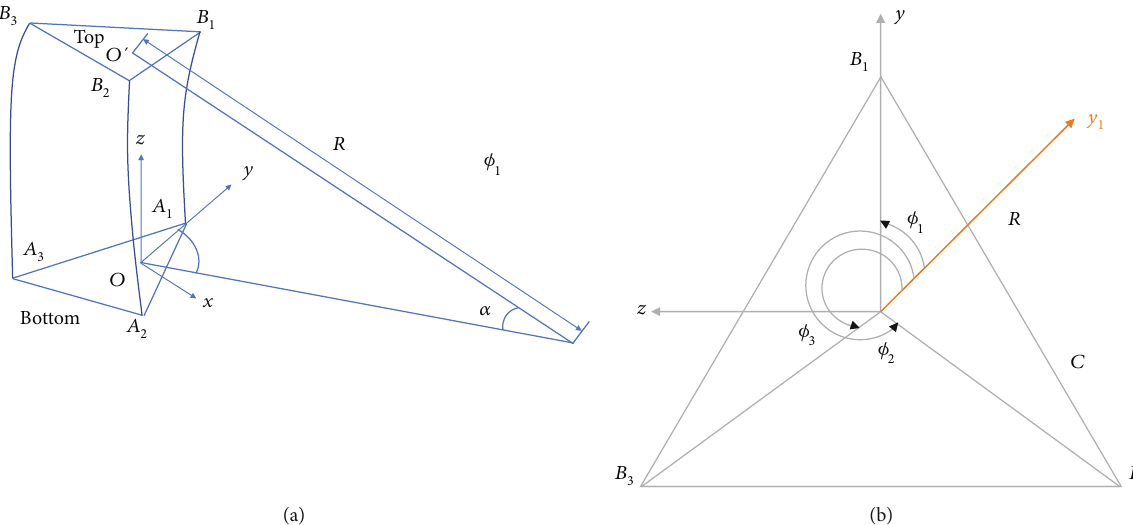
Figure 3: The introduced parameters in the robot: (a) the geometric display of a robot segment and (b) the display from the above of the robot platform.